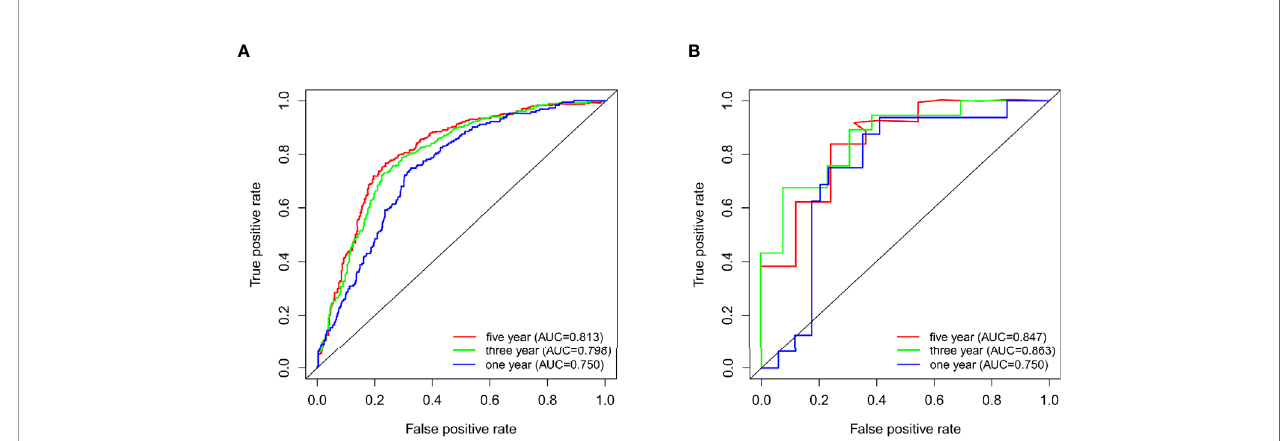
FIGURE 3 | (A) ROC curves for 1-, 3-, and 5-year survival of patients in CGGA. (B) ROC curves for 1-, 3-, and 5-year survival of patients in GSE43378.